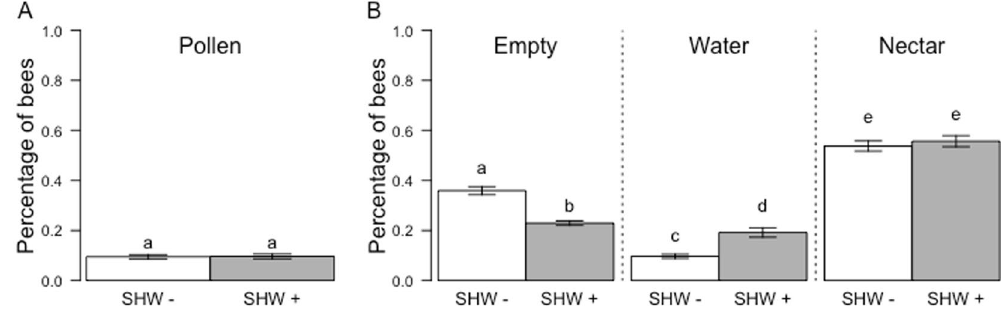
Figure 3. Proportion of pollen, nectar, water foragers and empty bees according to the SHW treatments. The mean percentage and standard error of bees foraging pollen ( A ) and other resources ( B ) are shown for bees sampled during an SHW − (white bars) or SHW + period (grey bars). For each forager category, different letters indicate significant differences (GLMM).